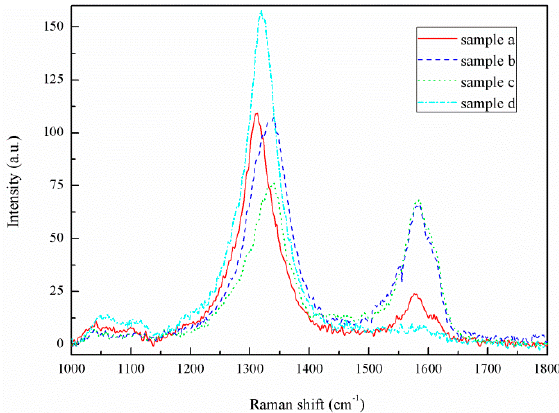
Figure 5. Raman spectra for the modified sample.